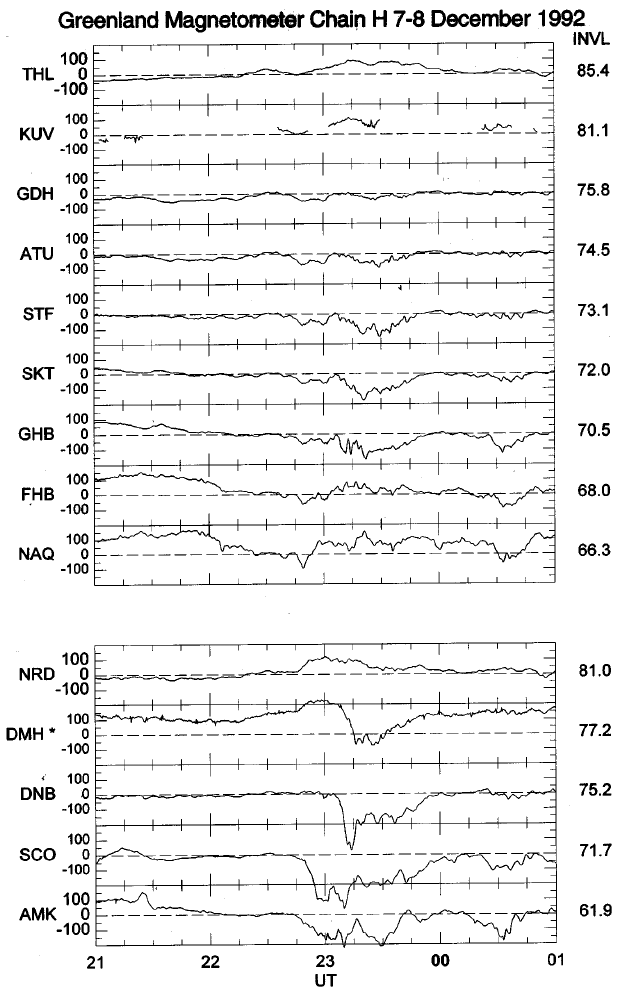
Fig. 6. The two panels show magnetic field data from the Greenland magnetometer chain for 21 UT, 7 December, 1992–01 UT, 8 December, 1992. The top panel is H -component data from the west coast chain (invariant latitudes 66.3–85.4 (cid:176) ) and the bottom panel from the east coast chain (latitudes 52.7–81.0